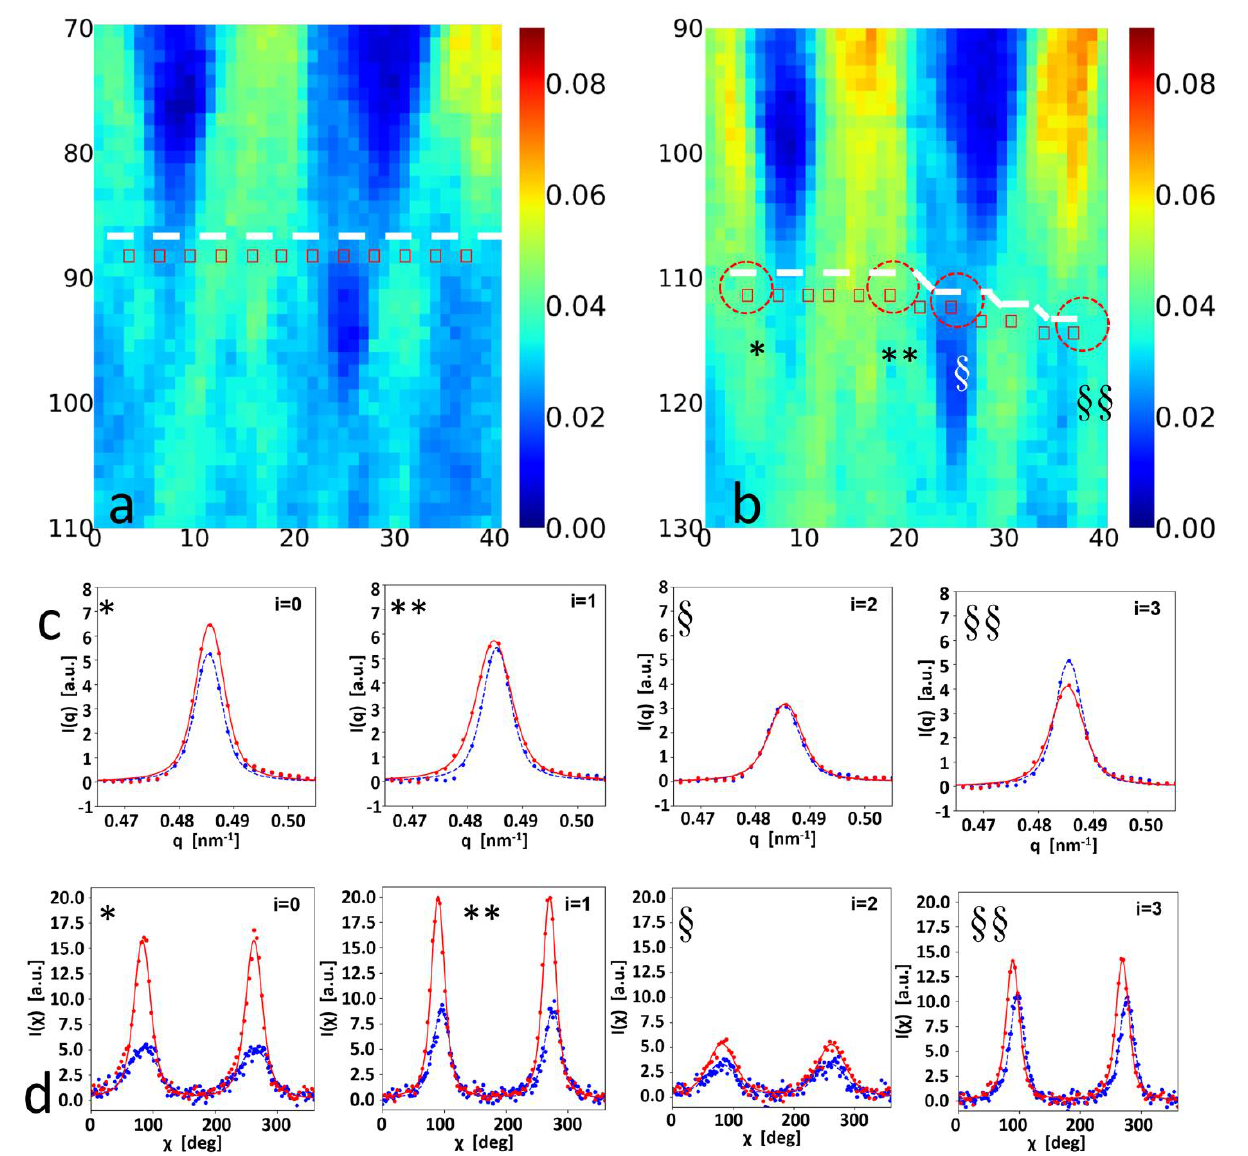
Figure 5. Digital image correlation (DIC) of SAXS contrast mapping for local fibrillar–level mechanics: ( a , b ) Colour–maps of background-corrected collagen peak intensity (used for DIC mapping) from keloid cross-sections in reference (left ( a ): 0%) and strained states (right ( b ): 20%). Left ( a ), red rectangles: selected set of SAXS patterns, on a horizontal line (dashed). DIC displacements ( u x , v y ) for each selected point used to calculate the displaced positions (right ( b ), red rectangles) and the distorted line (dashed). *, **, §, §§: selected points for detailed comparison in ( c , d ). ( c ): I(q) intensity profile around the 5th order collagen peak at 0% (blue: colour online) and 20% (red: colour online) strain for points at *, **, § and §§. *: increase in peak intensity, no peak shift; **: shift of peak to lower q, peak broadening; §: minimal change; §§: decrease in peak intensity. ( d ): Corresponding I( χ ) changes: *: decrease in peak width; **: increase in peak width; §: minimal change; §§: shift of peak aligning to the vertical